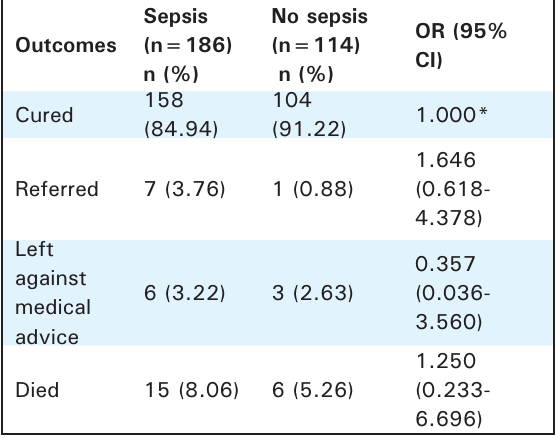
Table 4. Neonatal outcomes in relation to neonatal